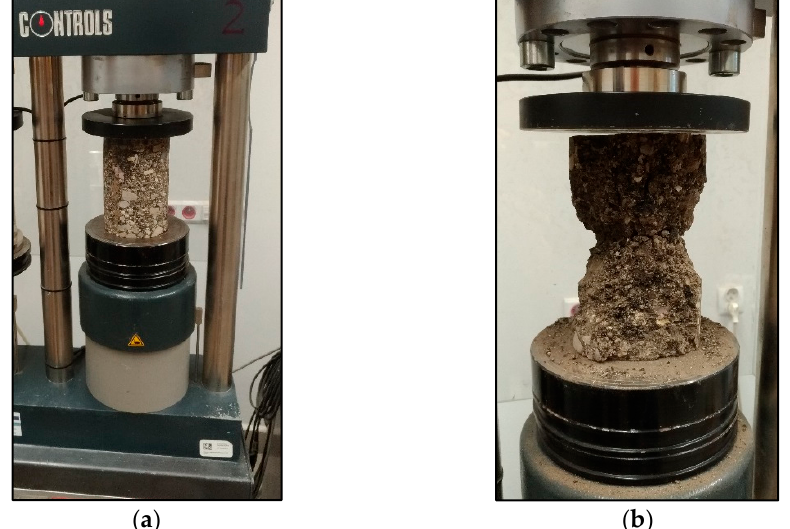
Figure 12. Mixture specimen in UCS testing after reaching ultimate compressive load: ( a ) before the compressive strength test; ( b ) after the compressive strength test [48].